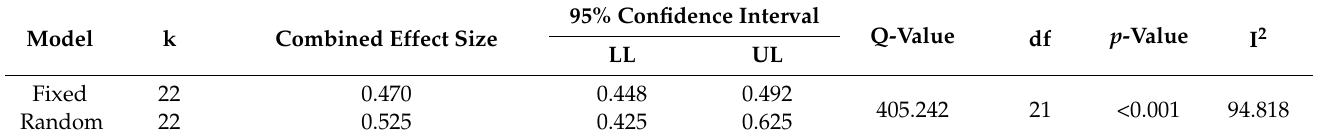
Table 4. Total sample heterogeneity test.